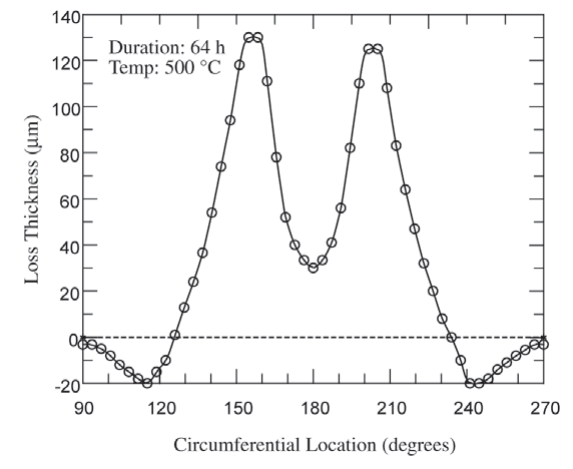
Figure 2. Typical circunferential distribution of wastage over the bottom half of the specimen rods, where the bottom is at